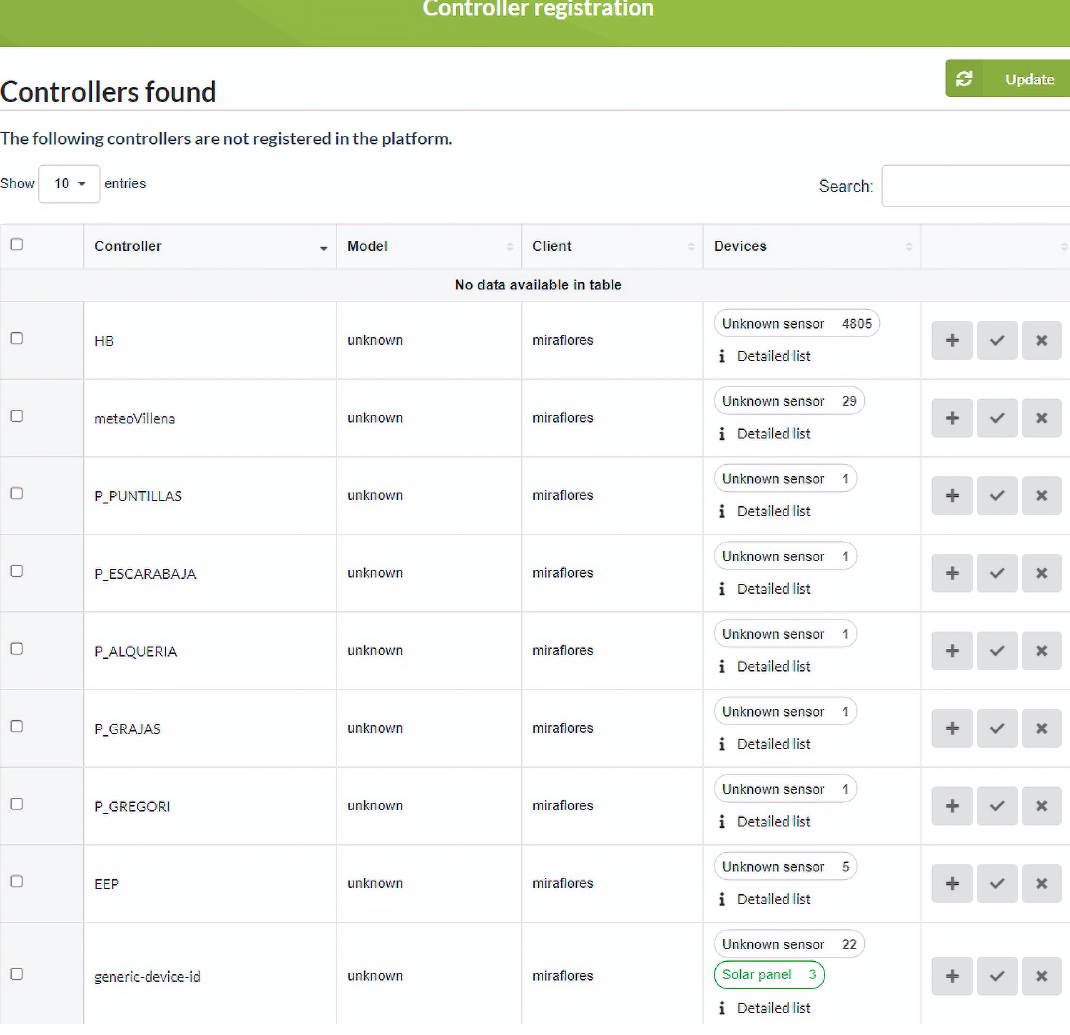
Figure 4. Controller registration module on the platform. Listing 1. Mex06 datalogger